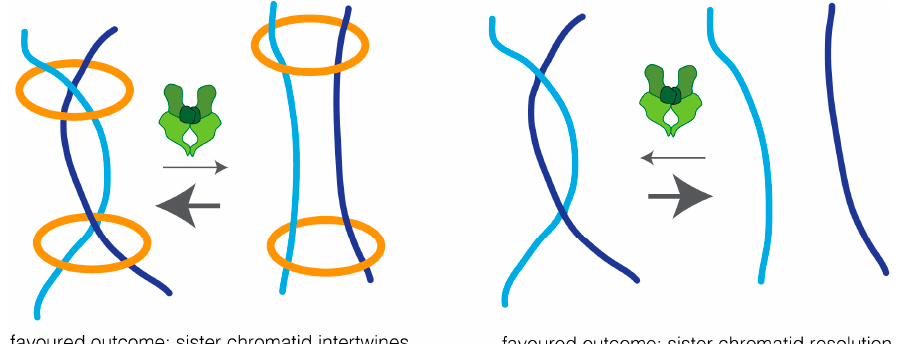
Figure 3. A proximity model for the regulation of topoisomerase II reactions by cohesin. Topoisomerase II undergoes bidirectional reactions, promoting both the resolution and re-catenation of DNA molecules. The cohesin complex (in orange) binds together two DNA molecules (in light blue and dark blue respectively), bringing them in close proximity. Such closeness can increase the chances of topoisomerase II-driven catenation of those strands, and thereby shifts the equilibrium towards the catenated state. Removal of cohesin results in physical separation of DNA molecules, rendering them unlikely to re-entangle once topoisomerase II separates them. Thus, upon cohesin removal, the equilibrium shifts, favoring sister chromatid resolution.